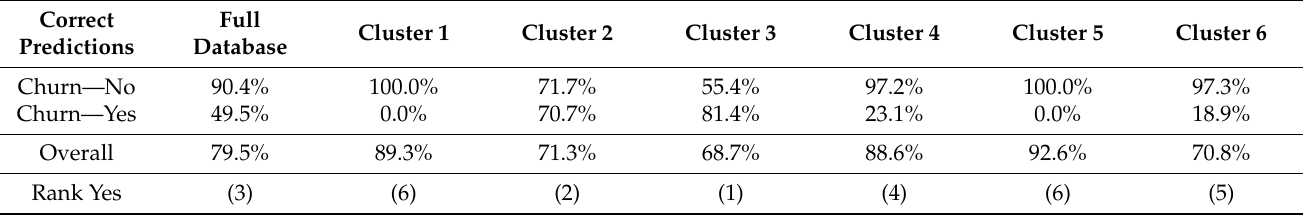
Table 7. Percentage of correct churn classifications for CHAID decision